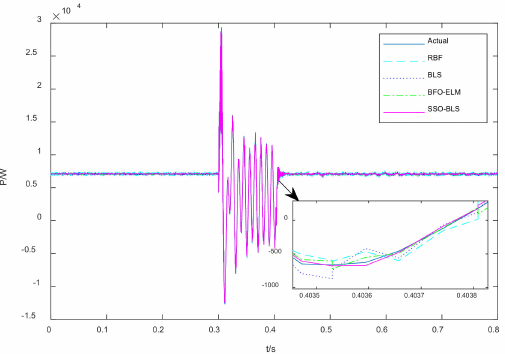
Figure 3. Power comparison of DC microgrids grid-connected points in AC grids with single–phase short–circuit fault.